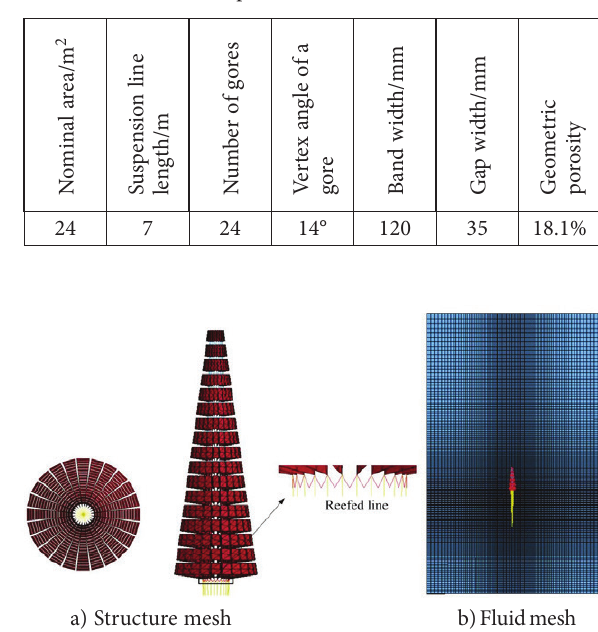
Table 1. Geometrical parameters of the conical ringslot parachute model